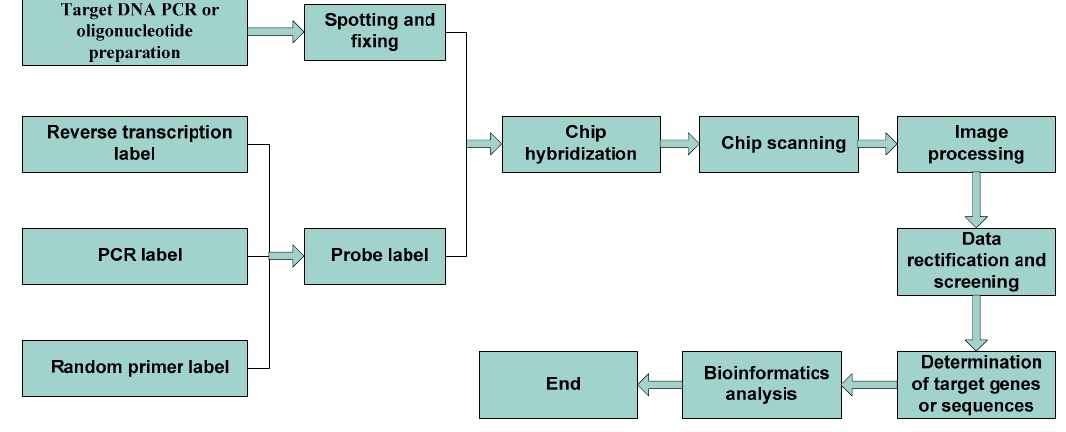
Figure 1. Steps of gene chip technology.